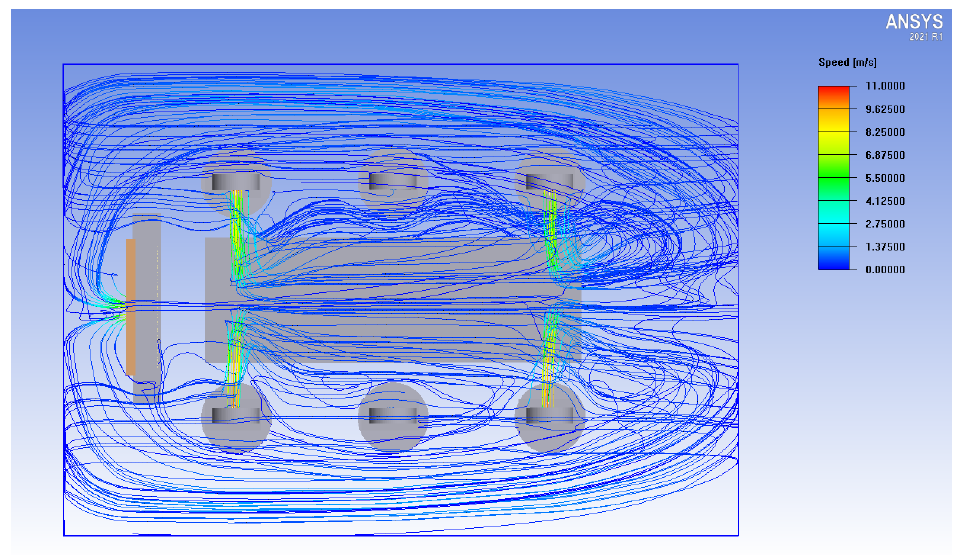
Figure 32. Air purification equipment high-speed simulation results placed in a conference room − 2.